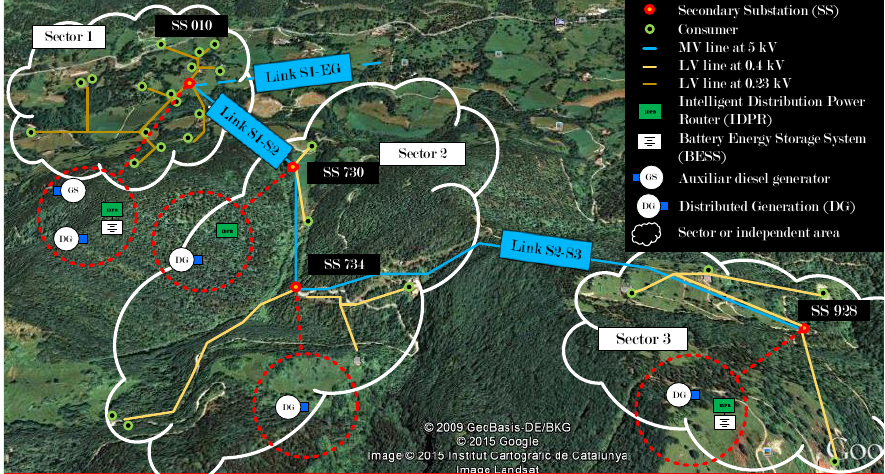
Figure 6. The Pilot Network divided into three sectors